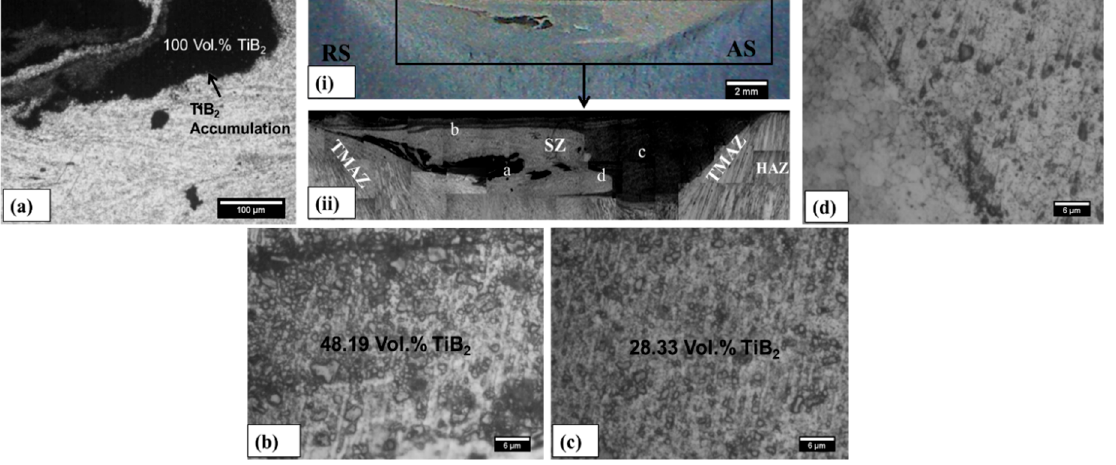
Figure 8. ( i ) Macro-image of cross-section of Sample 2. ( ii ) Microstructure of cross-section of the rectangle in macro-image showing: ( a ) agglomerated region; ( b ) mixed region; ( c ) dispersed region; and ( d ) AS interface.